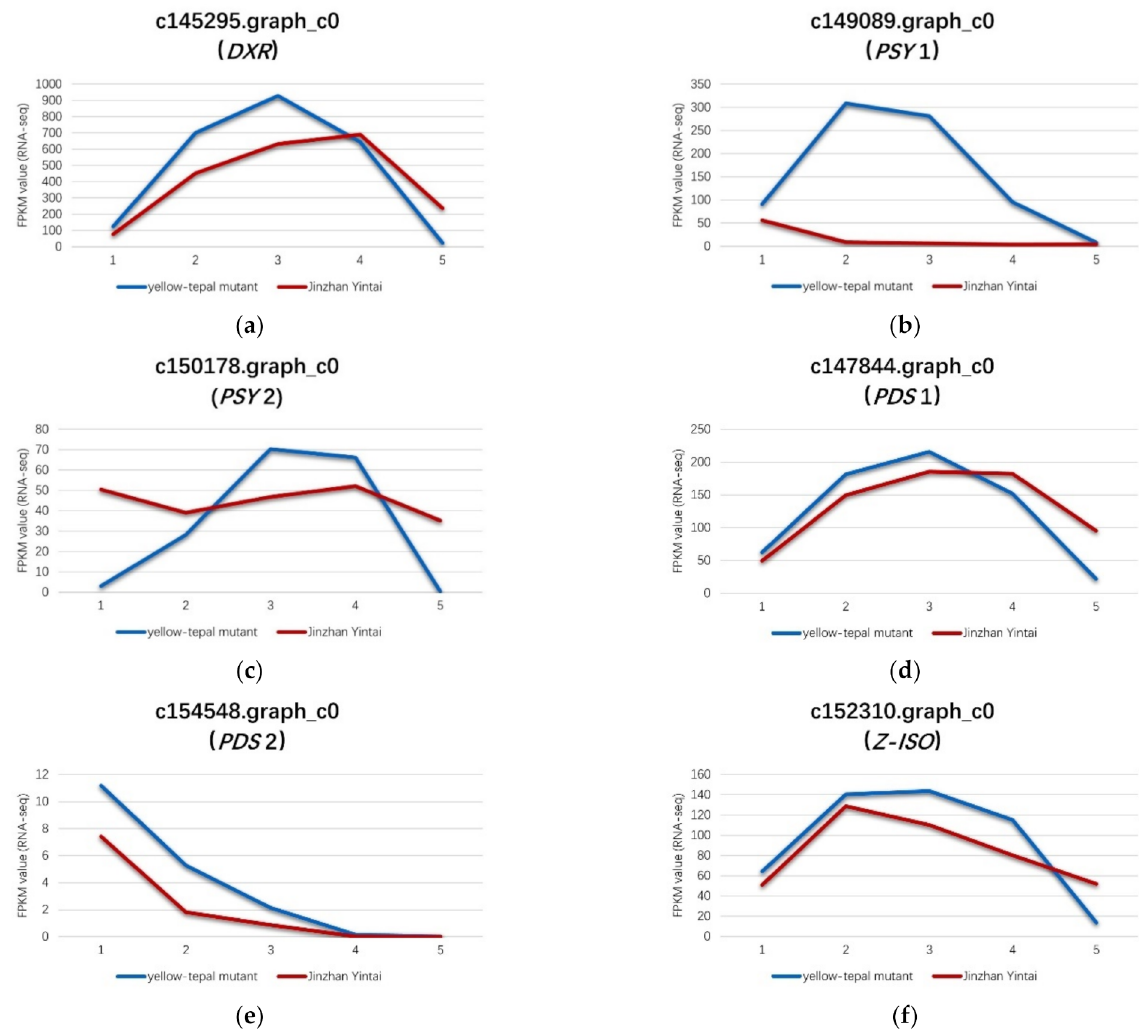
Figure 7. Expression levels of six key genes in ‘Jinzhan Yintai’ and its yellow mu- tant. ( a ) c145295.graph_c0, ( b ) c149089.graph_c0, ( c ) c150178.graph_c0, ( d ) c147844.graph_c0, ( e ) c154548.graph_c0, ( f ) c152310.graph_c0. The blue line represents the expression level of the gene in the yellow mutant, while the red line represents the expression level of the gene in ‘Jinzhan Yintai’. The present data revealed that the Z-ISO gene (c152310.graph_c0) was up-regulated in the yellow mutant. The Z-ISO enzyme catalyzes the conversion of 9,15,9 (cid:48) - trans - cis - ζ - carotene to 9,9 (cid:48) -di- cis - ζ -carotene (Figure 7). In plants, NCED is an important enzyme involved in carotenoid decomposition and ABA synthesis. We found that two NCED genes (c155128.graph_c0 and c152665.graph_c1) were significantly down-regulated in the yellow mutant, whereas their expression was up-regulated in ‘Jinzhan Yintai’ (Figure 8). This result suggested that low-expressed NCEDs may inhibit carotenoid degradation in tepals of the yellow mutant, which contributed to the accumulation of carotenoids in tepals. For ‘Jinzhan Yintai’, the limited amount of carotenoids synthesized in the early stages of flower development were likely to be decomposed quickly under the high activity of NCED, which furtherly activated the ABA production for uncertain